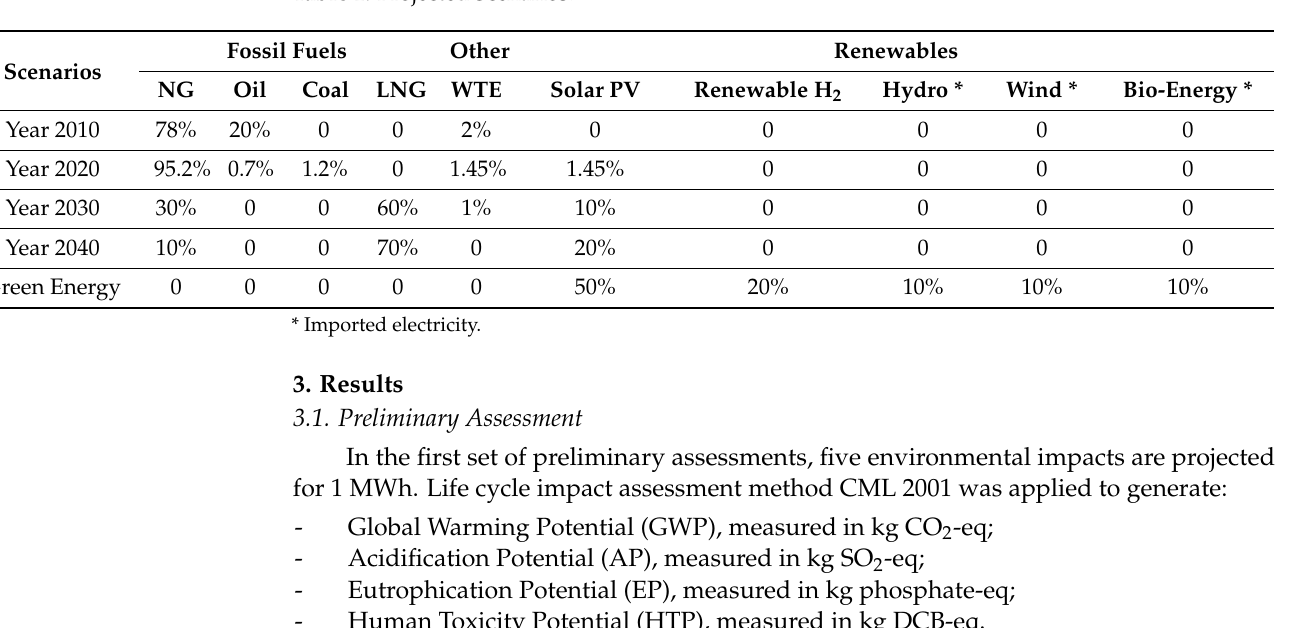
Table 1. Projected Scenarios.